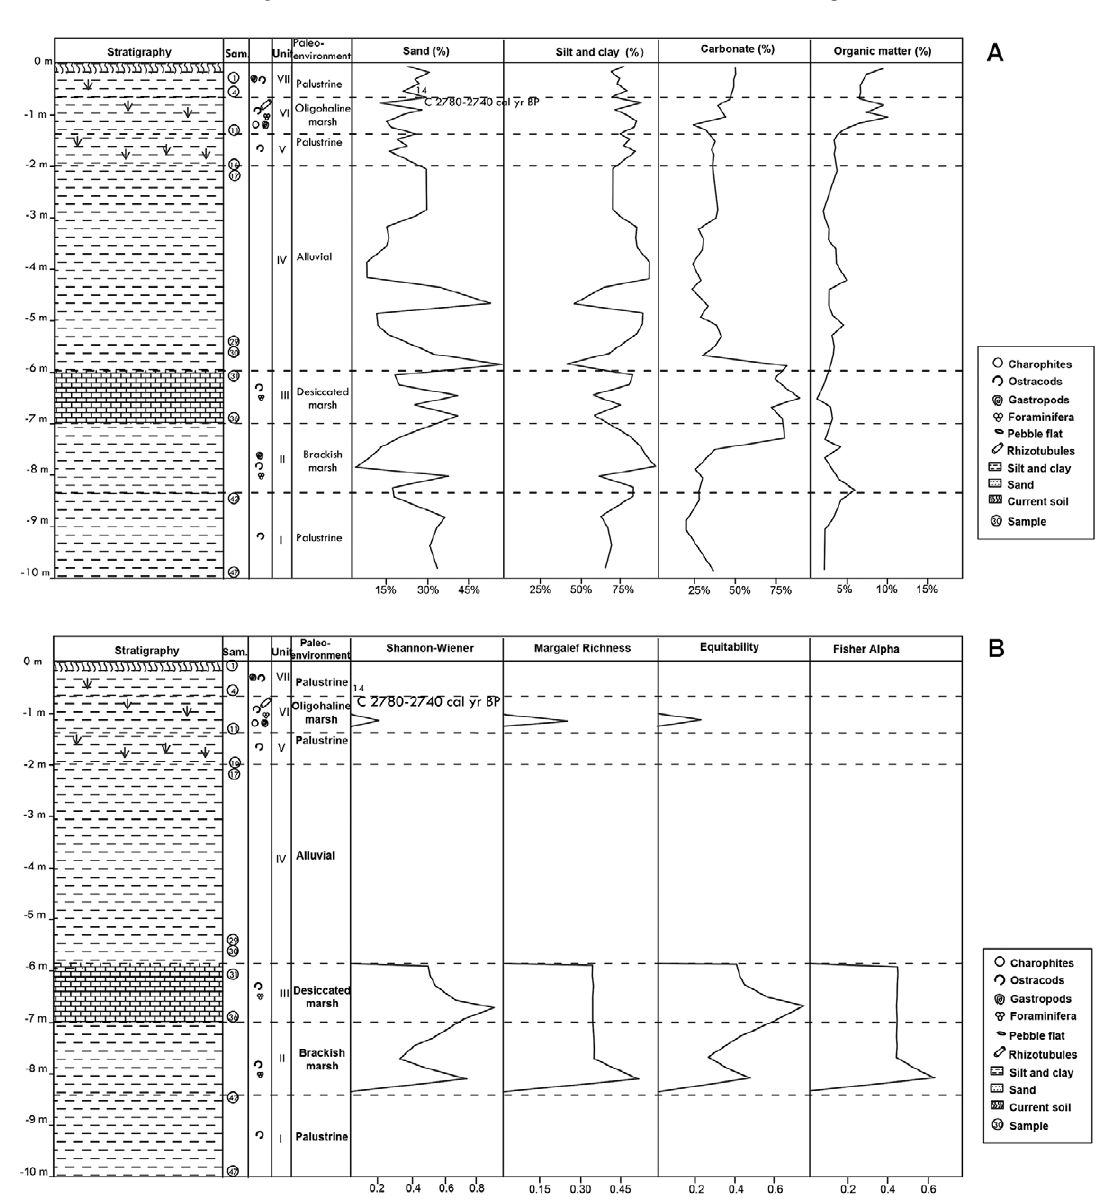
(%). A palaeoenvironmental in- 3